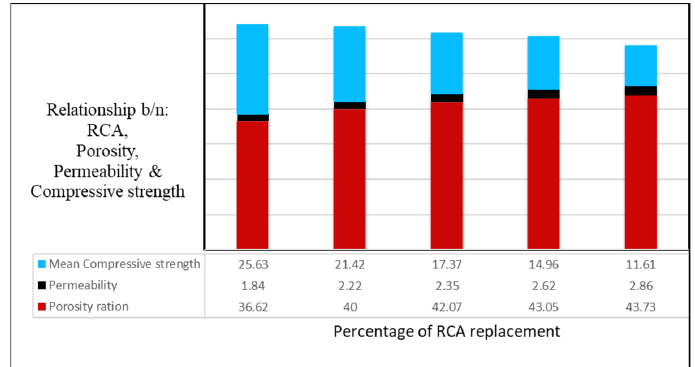
Figure 8. Relationship between RCA, porosity, permeability, and compressive strength.